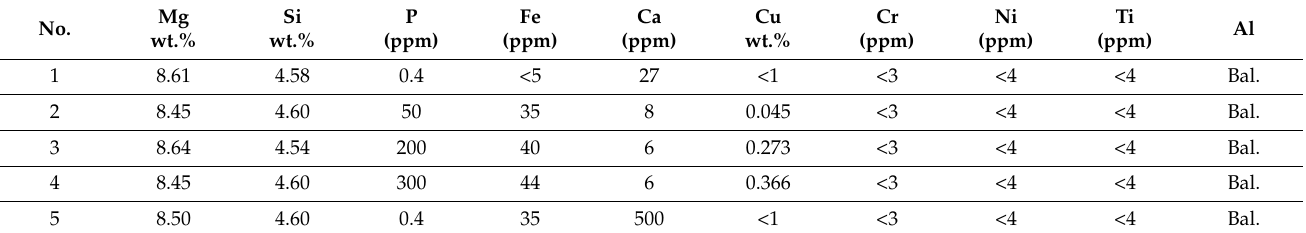
Figure 1. ( a ) Cast iron permanent mold used for casting, ( b ) photograph of actual cast part and ( c ) sketch showing the die dimensions (unit: mm). The white arrows from left to right indicate the pro- vision in the die for the filter placement, casting cavity and the cutting of samples for microstructural characterization, respectively. Table 1. Measured composition of five alloys manufactured for this investigation.